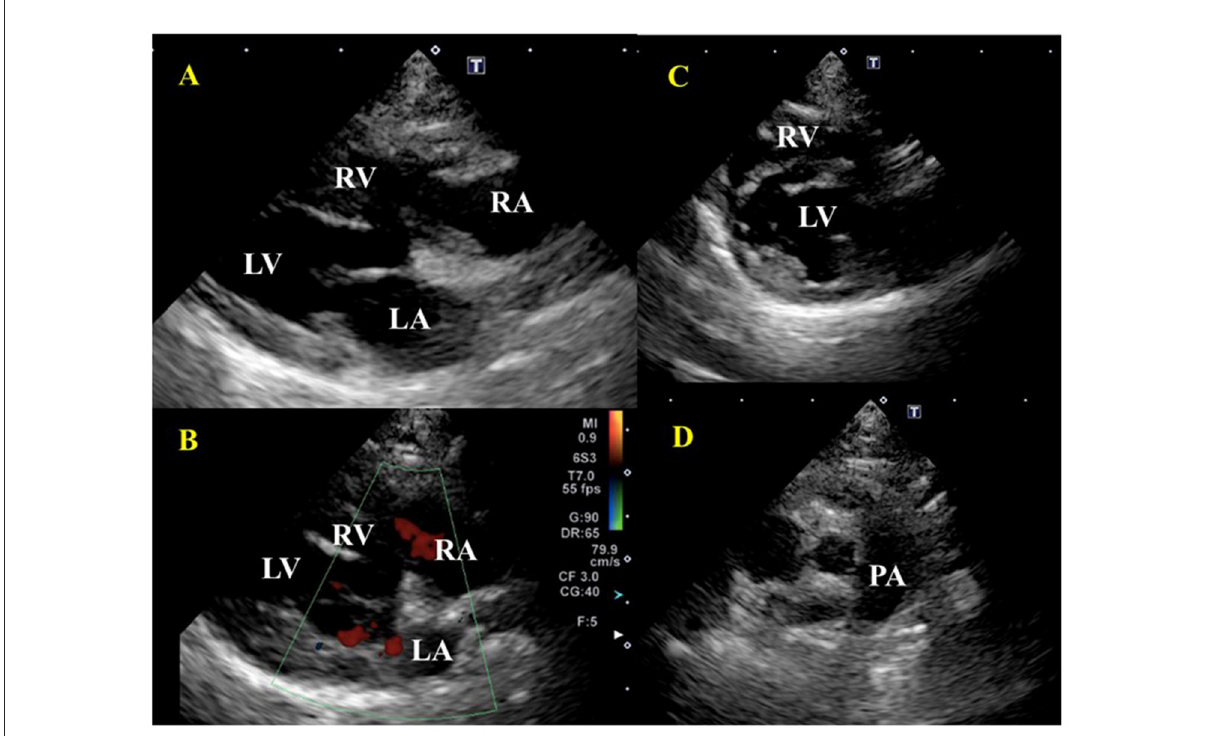
FIGURE4 Echocardiographic images after treatment of a cat diagnosed with IMHA and pulmonary thromboembolism on Day 21. (A) Right parasternal long-axis view. There was no enlargement of the right atrium and right ventricle. (B) Right parasternal long-axis view (Color Doppler imaging), tricuspid valve regurgitation had disappeared. (C) Right parasternal short-axis view (Apical level). Right ventricular enlargement and flattening of the ventricular septum disappeared. (D) Right parasternal short-axis view (Basal level). A thrombus in the pulmonary artery had disappeared. RA, right atrium; RV, right ventricle; LA, left atrium; LV, left ventricle; PA, pulmonary